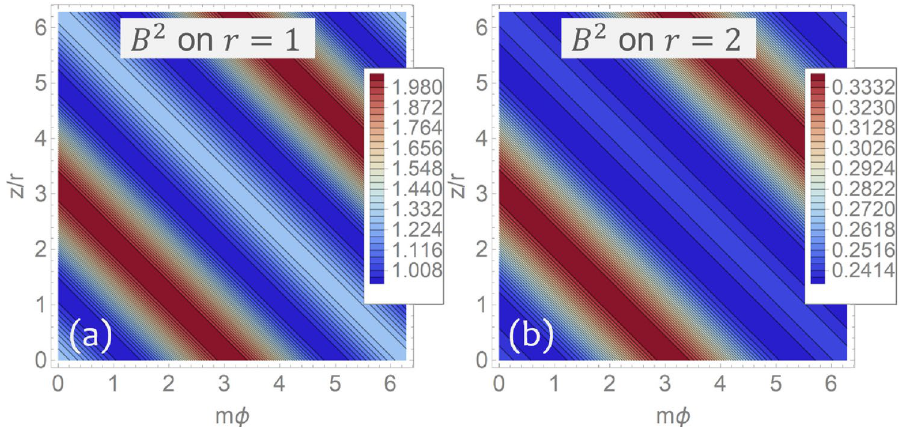
Figure 4. Modulus B 2 ( r , m ϕ + z / r ) of the quasisymmetric magnetic field (15a) for ǫ = 0.2 and m = 4 as seen in the ( m ϕ , z / r ) plane for different values of the radial coordinate r . ( a ) Plot on the level set r = 1 . ( b ) Plot on the level set r = 2 . Observe how contours of B 2 form straight lines. Figure created using Wolfram Mathematica 12.2 (www.wolfram.com/mathematica).